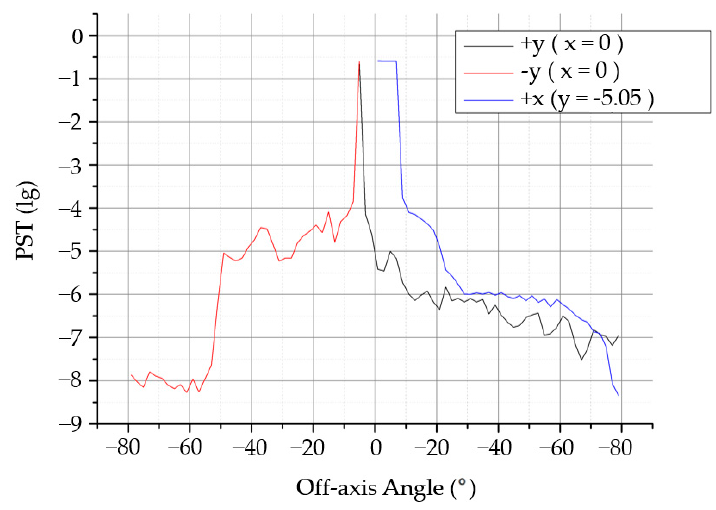
Figure 8. Analysis curve of the modulation transfer function (MTF).